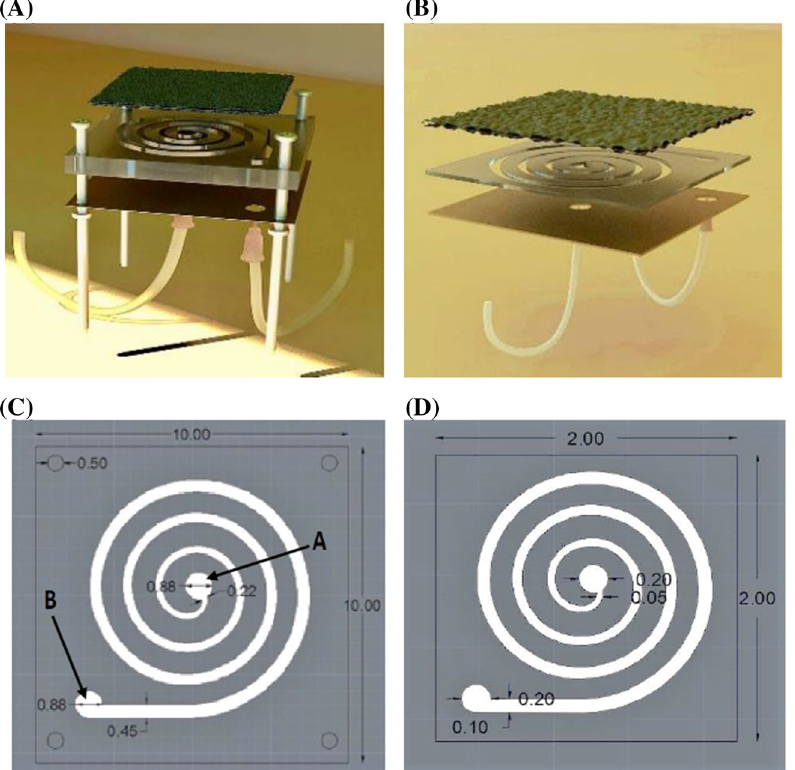
Figure 1. 3D schematic images for ( A ) the macro-scale and ( B ) micro-scale MFCs. Images and dimensions of ( C ) the macro-scale and ( D ) micro-scale MFCs. ( A ) and ( B ) show the inlet and outlet, respectively. The scale is millimeter. The used poly (methyl methacrylate) (PMMA) sheets were produced by Cho Chen Industry Co. LTD, Taiwan. The spiral path of the microchannel was drawn by AutoCAD and the file was exported to the laser machine (Non-Metal Laser Cutting Machine, Model CMA1390-LG, GD Han’s Yueming Laser Group Co., LTD). (AutoCAD 2015, URL: https:// www. autod esk. com/ produ cts/ autoc